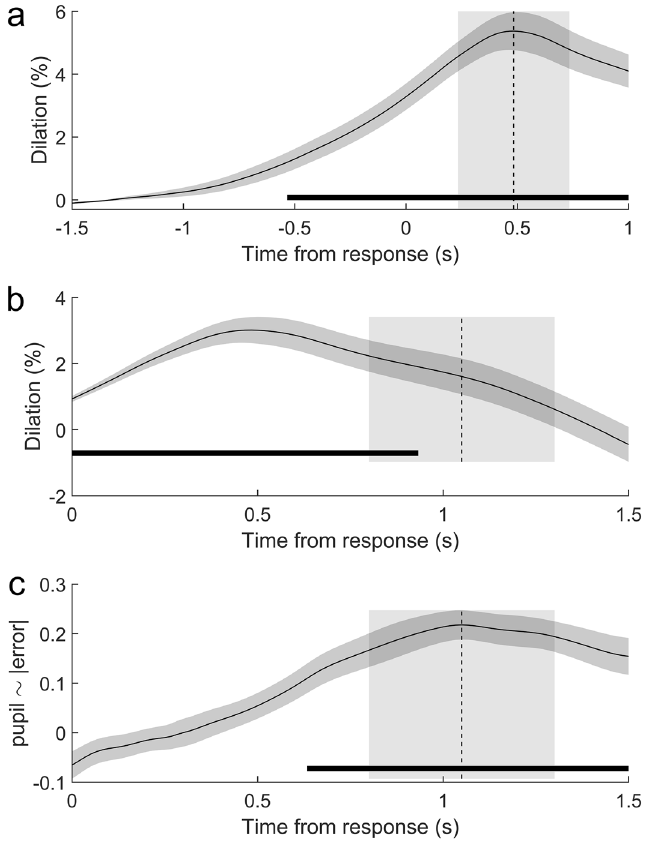
Figure 3. Pupil traces during time estimation task. Pupil traces (mean and standard error) baseline-corrected relative to a pre-stimulus ( a ) and pre-response period ( b ), as well as regression of feedback-related pupil- response on performance error ( c ). Data are time-locked to the time of response (and feedback).